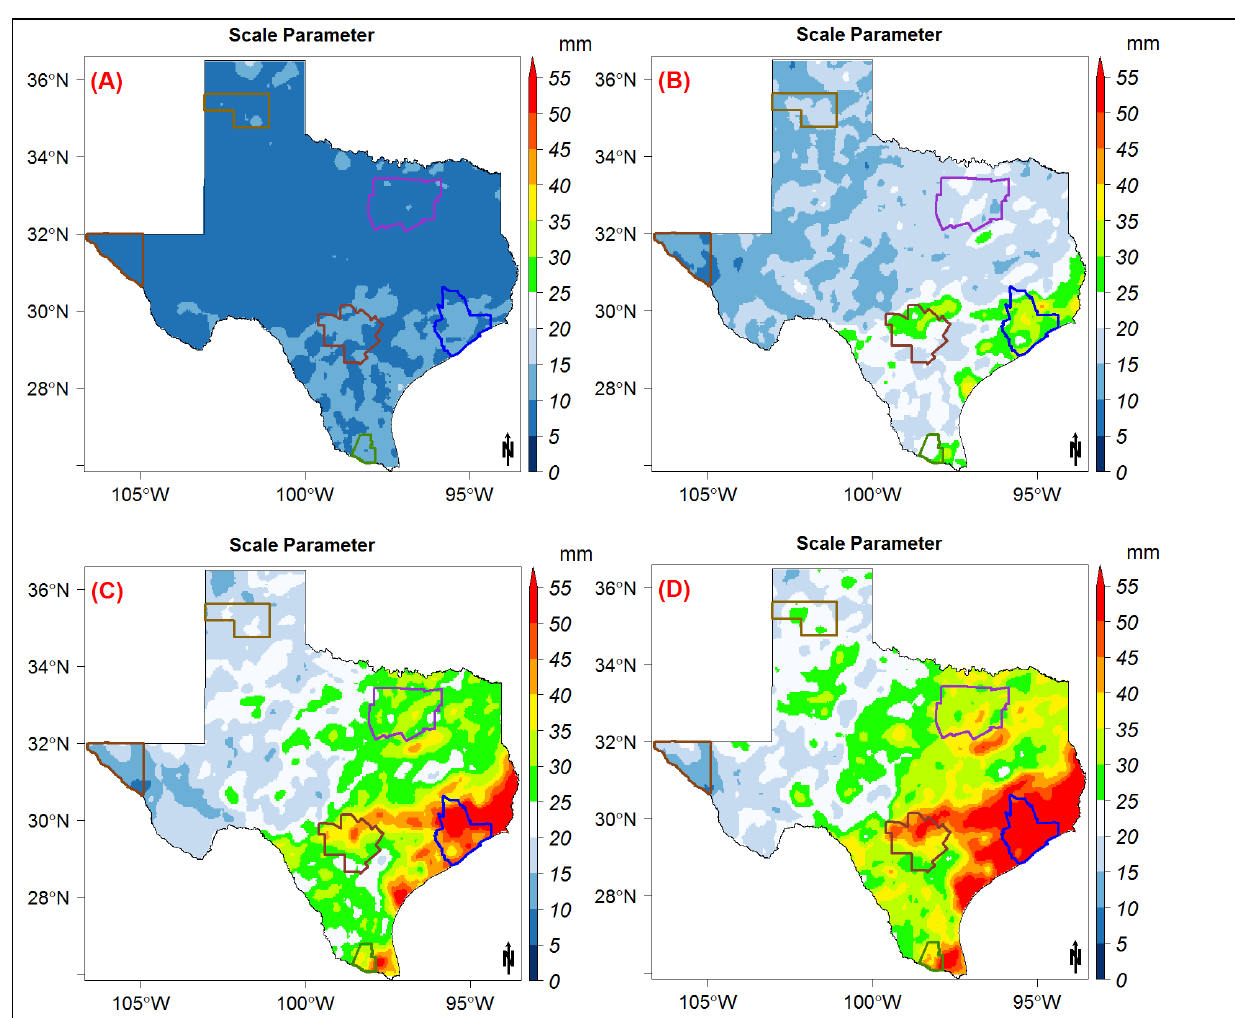
Figure A2. Scale parameters of the Gumbel model distribution for the ( A ) 1-h, ( B ) 6-h, ( C ) 24-h, and ( D ) 48-h storm dura- tions.